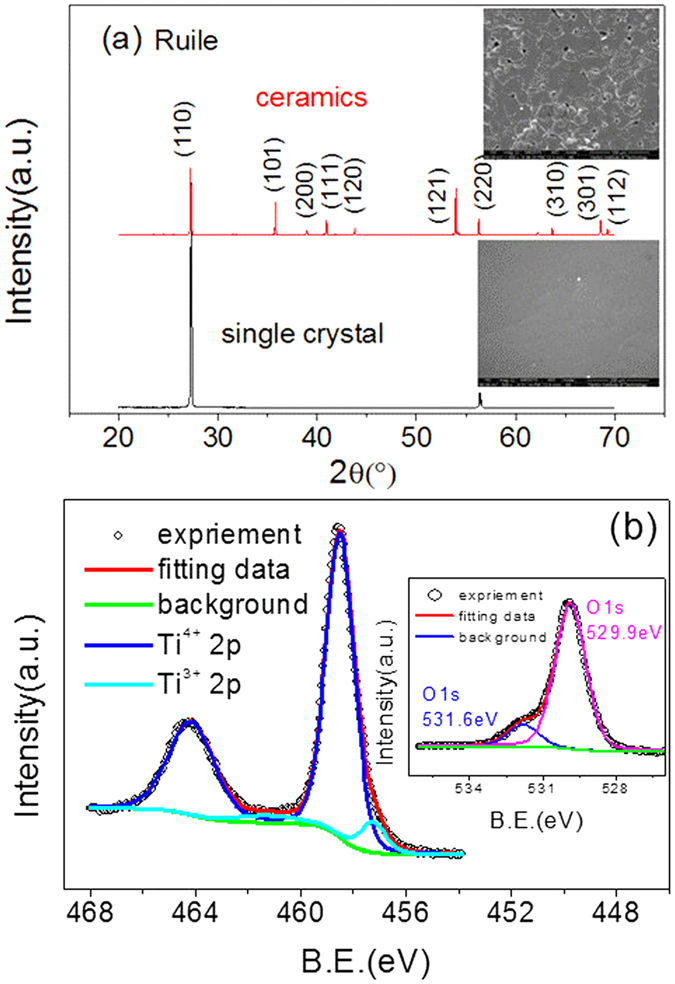
(a) XRD pattrens and SEM images of In0.05Nb0.05Ti0.9O2 single crystal (black line) and polycrystalline ceramics (red line); (b) Valence states of the elements Ti in the TiO2 single crystal co-doped with 10% (In + Nb), the insert shows the XPS data of O1s.